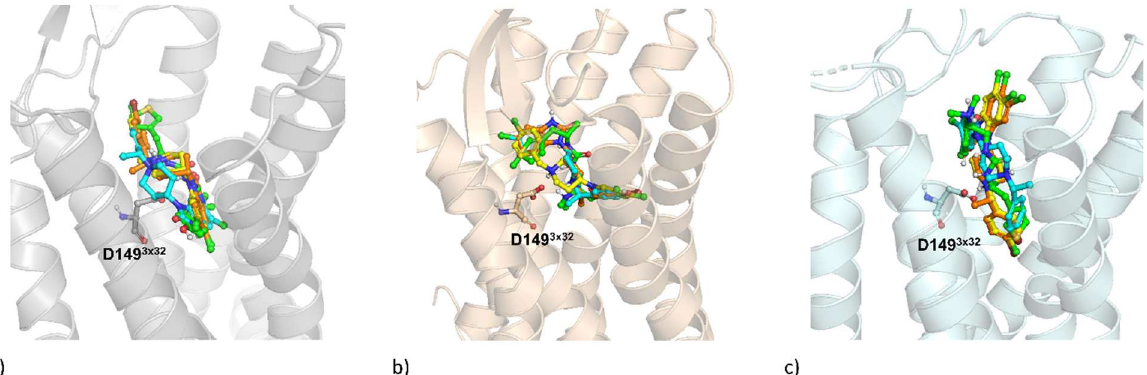
Figure 6. Docking results of PZM-21 (green), (R)-SR-14968 (cyan), (S)-SR-14968 (orange), SR-17018 (yellow) to ( a ) 4DKL, ( b ) 5C1M, and ( c ) 6DDF crystal structures of the μ-opioid receptor. The amino acid numbers presented in superscript follow the GPCRdb numbering scheme [24].